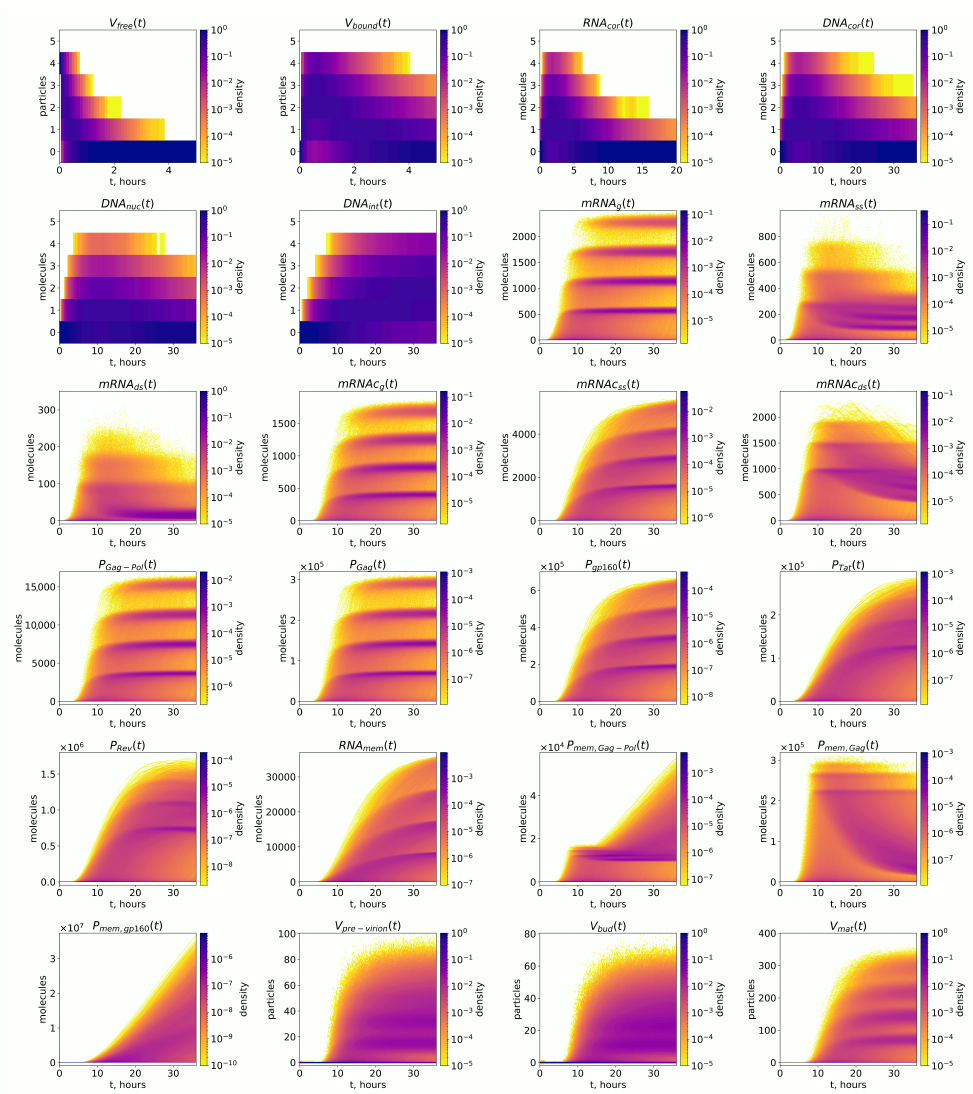
Figure 4. Temporal evolution of the histograms of the stochastic model variables for the initial condition [ V free ]( 0 ) =